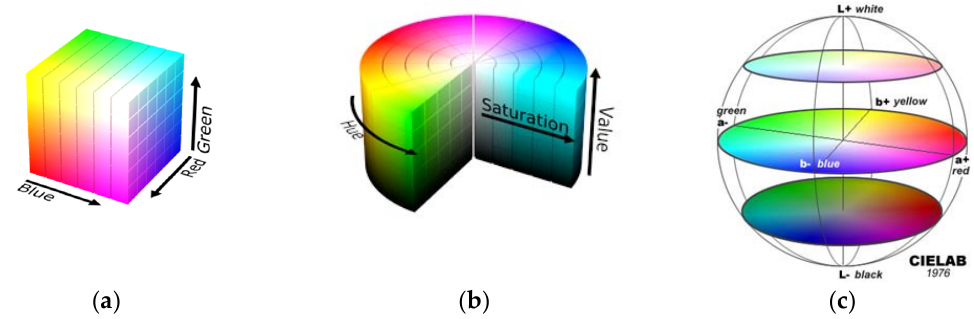
Figure 5. ( a ) RGB color space, ( b ) HSV color space, ( c ) CIELab color space.